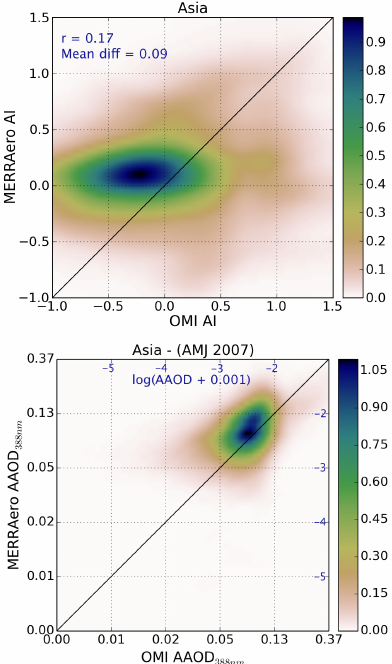
Figure 17. Same as Fig. 12 but for the Asian region during AMJ